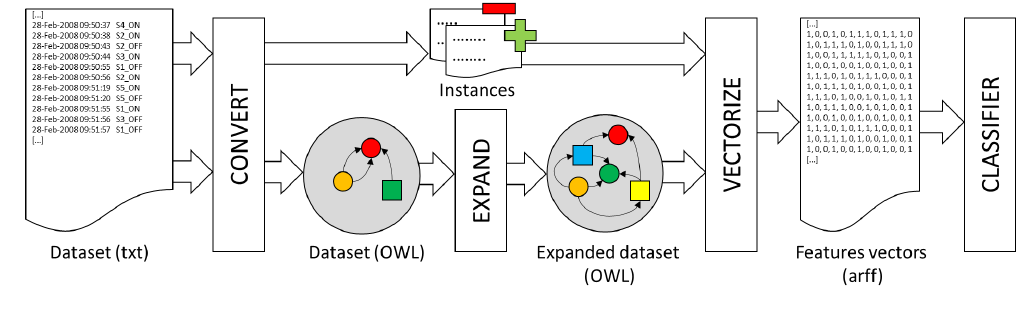
Figure 2. Functional